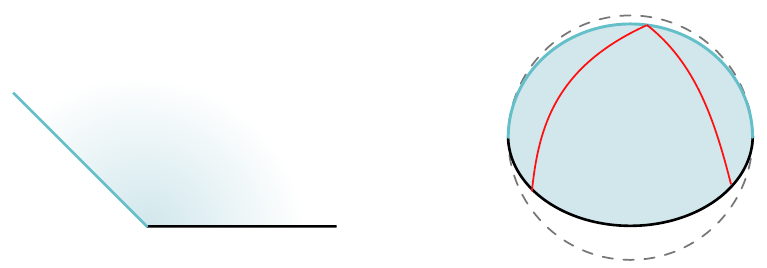
Figure 7. (a) A 2D spatial-slice of AdS 3 cutoff by an ETW brane. (b) The same spatial slice conformally mapped to part of the two-sphere. The path of a null geodesic is marked in red.